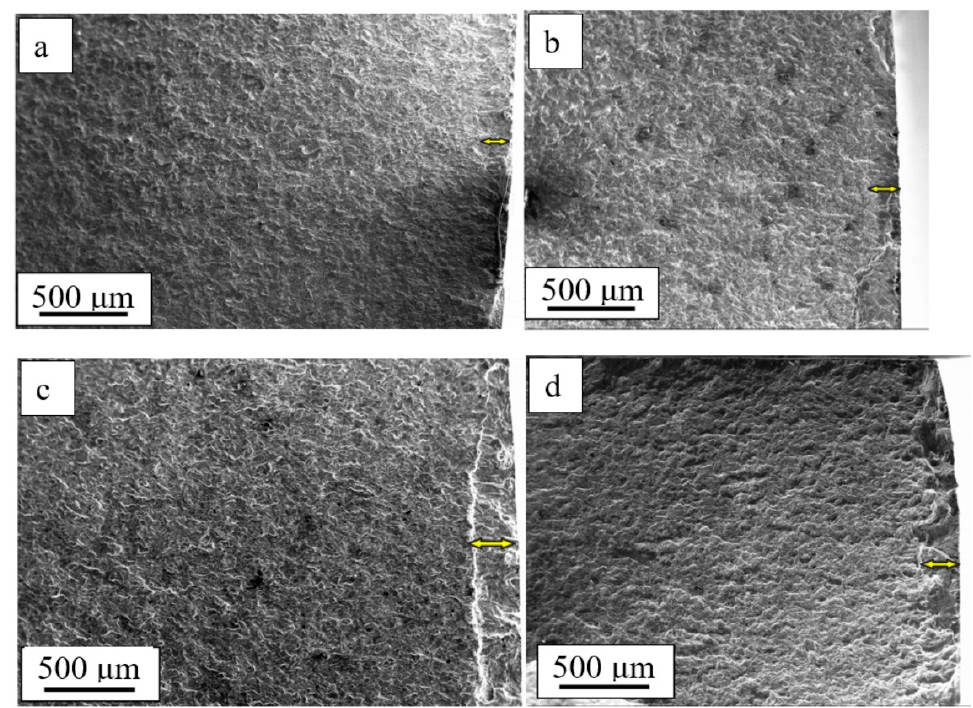
Figure 5. Structure of the titanium fracture surface subjected to fatigue tests in the magnetic field: ( a ) 0 T; ( b ) 0.3 T; ( c ) 0.4 T; ( d ) 0.5 T. The arrow indicates the zone of fatigue crack growth.